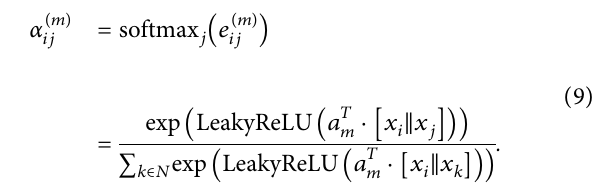
learned by single-view attention network in view m .